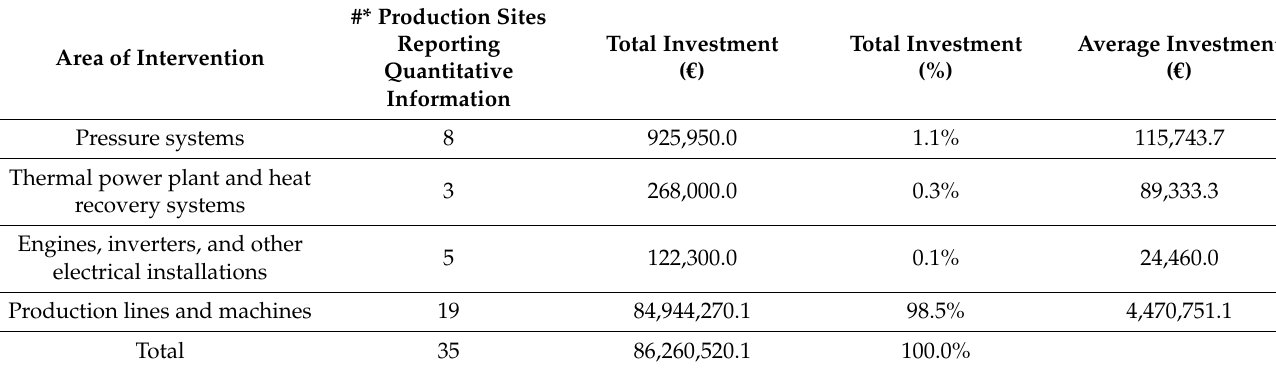
Table 5. Investments required to apply technological